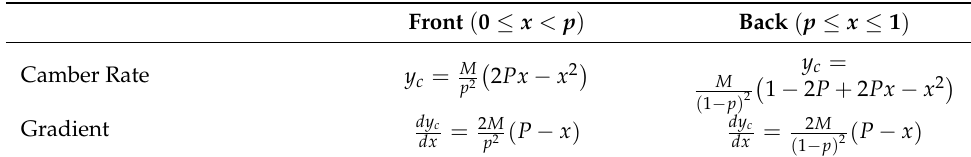
Table 1. Camber rate and gradient of geometry for airfoil description.